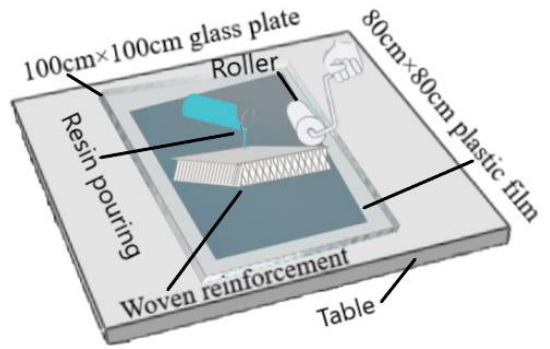
Figure 2. Schematic diagram of the hand lay-up technique.